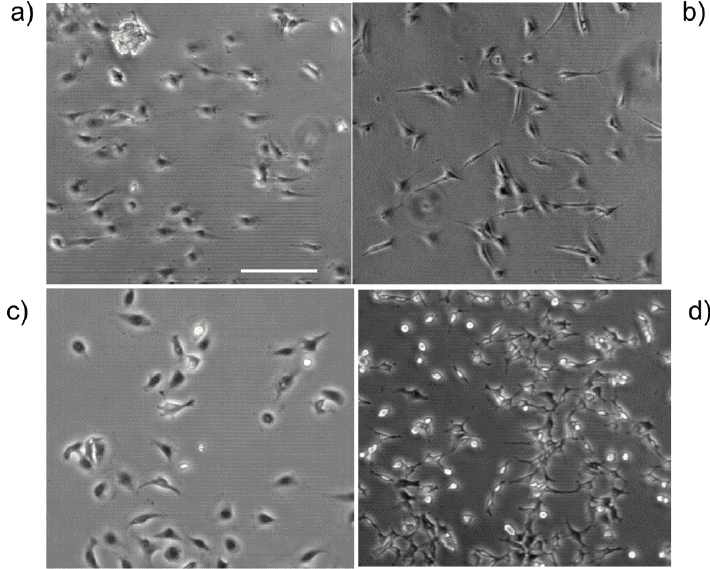
Figure 2. Representative phase contrast images of each cell line on the high slope gradient, where ( a ) IOSE; ( b ) OVCA433; ( c ) SKOV-3.ip1; and ( d ) HEY-1. The gradient increases in concentration from left to right. Scale bar = 200